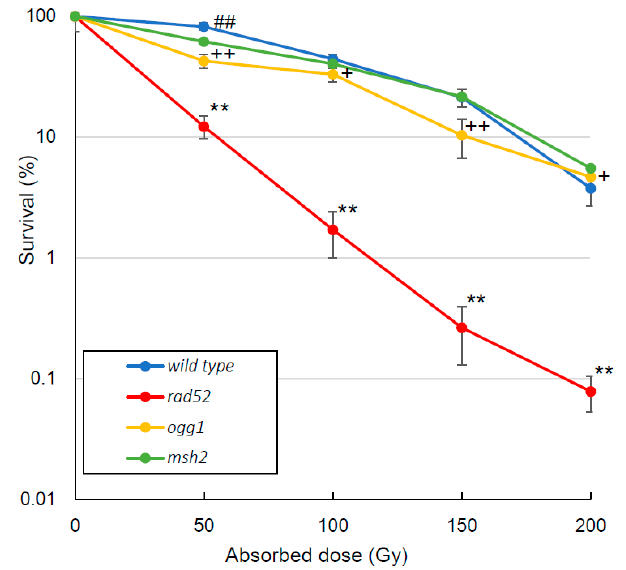
Figure 1. Survival rates for yeast strains S288c (wild-type), rad52 , ogg1 , and msh2 after irradiation by carbon ion beams. Data are the means of five replicates. Data for yeast strain S288c (wild-type) were taken from [12]. Bars indicate SD. rad52 vs wild-type; ** P < 0.01, ogg1 vs wild-type; + P < 0.05, ++ P < 0.01, msh2 vs wild-type; ## P < 0.01.